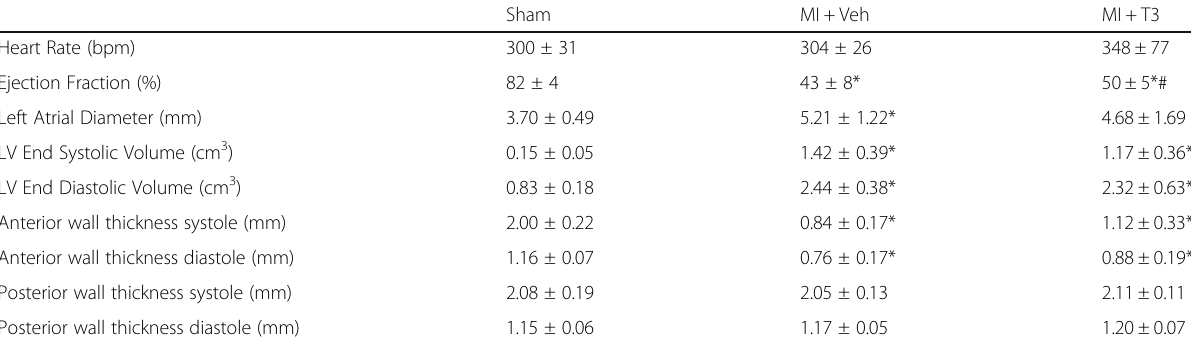
Table 1 Left ventricular echocardiographic measurements